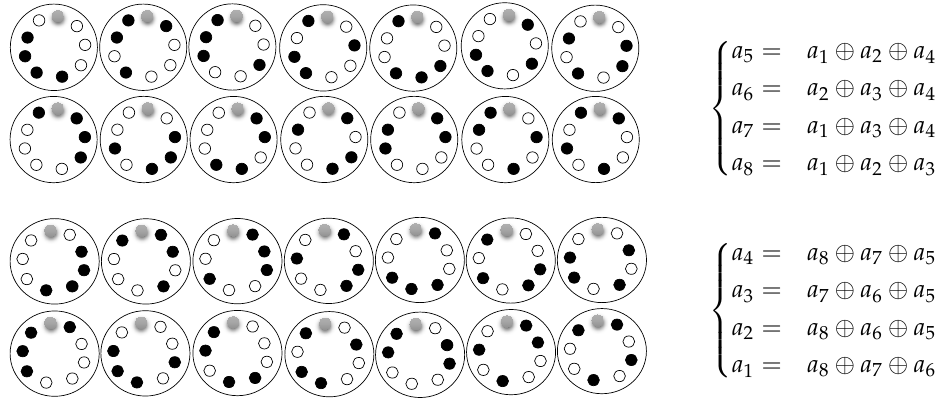
Figure 2. Two more Latin matchings of order 5 (which are symmetric to each